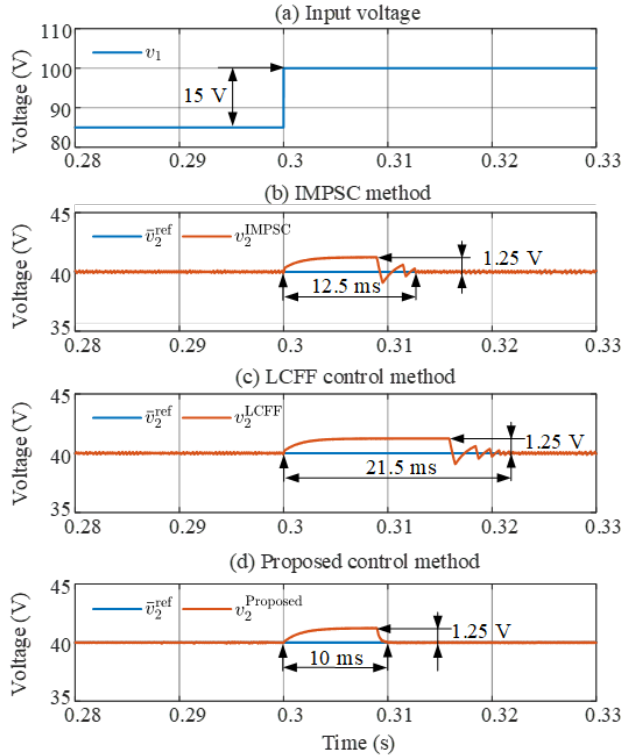
Figure 10. Simulation results of the output voltage when the input voltage steps up from 85 V to 100